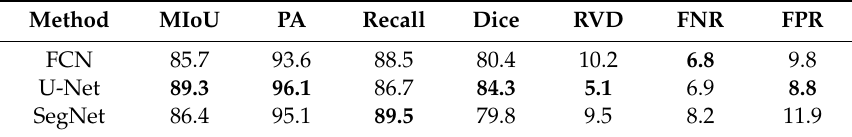
Table 5. Results of di ff erent evaluation metrics under di ff erent networks.